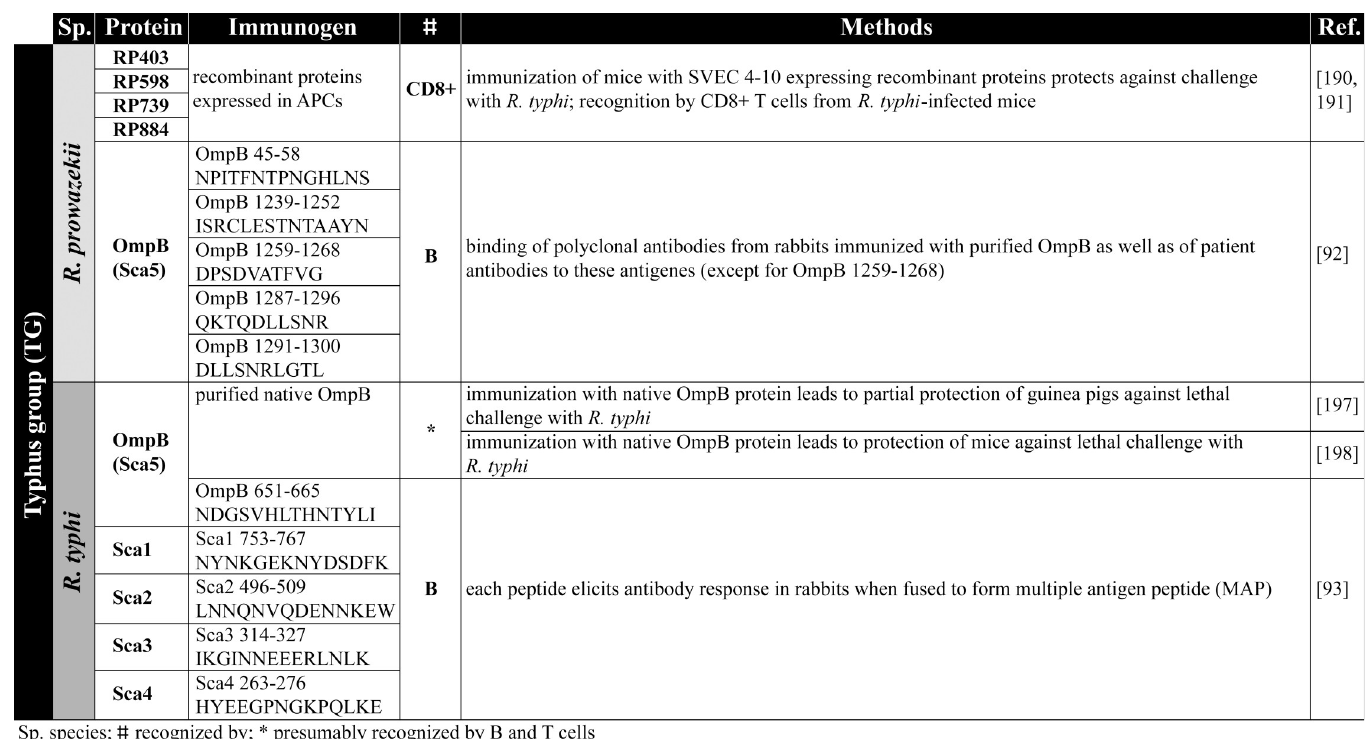
Fig 2. TG antigens. The figure summarizes the antigens identified from TG rickettsiae [92,93,190,191,197,198]. APCs, antigen-presenting cells; MAP, multiple antigen peptide; TG, Typhus group.